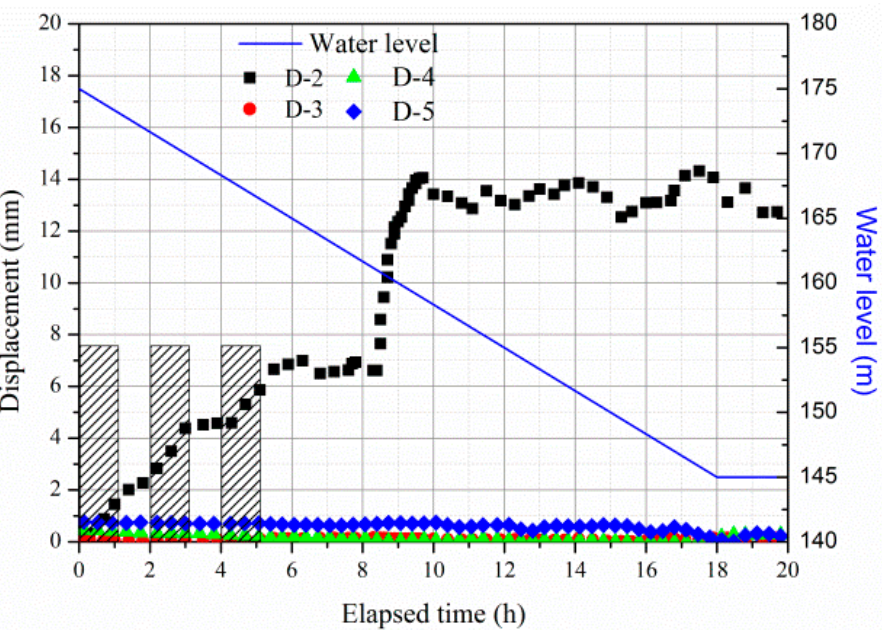
Figure 14. Displacements observed during the water lowering process combined with the rainfall simulations.